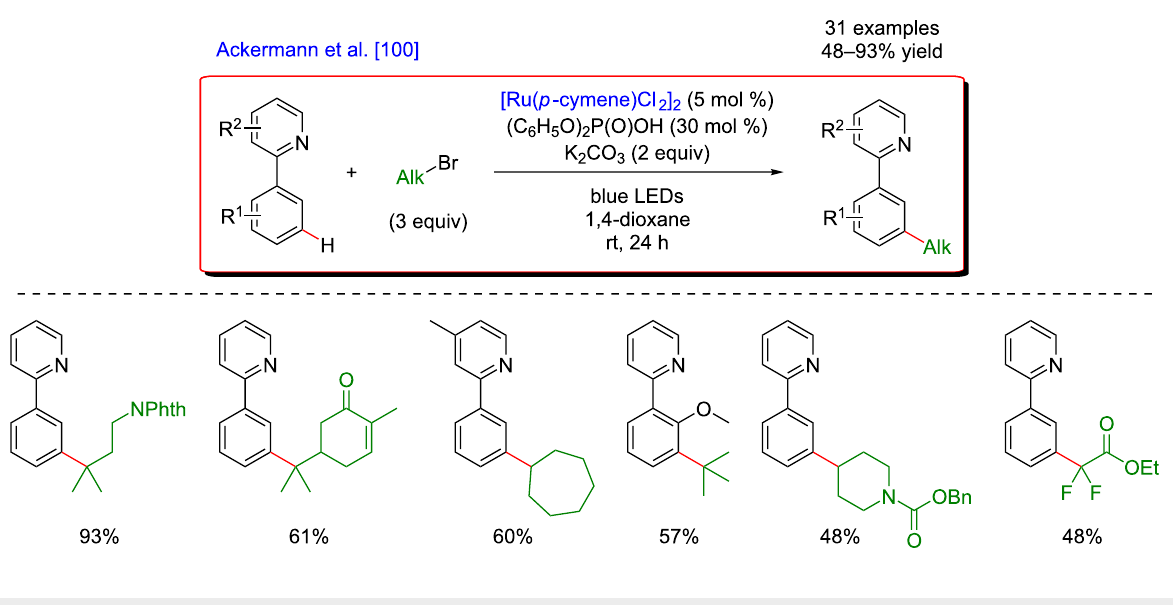
Figure 37: meta -C–H Alkylation of arenes via visible-light metallaphotocatalysis.